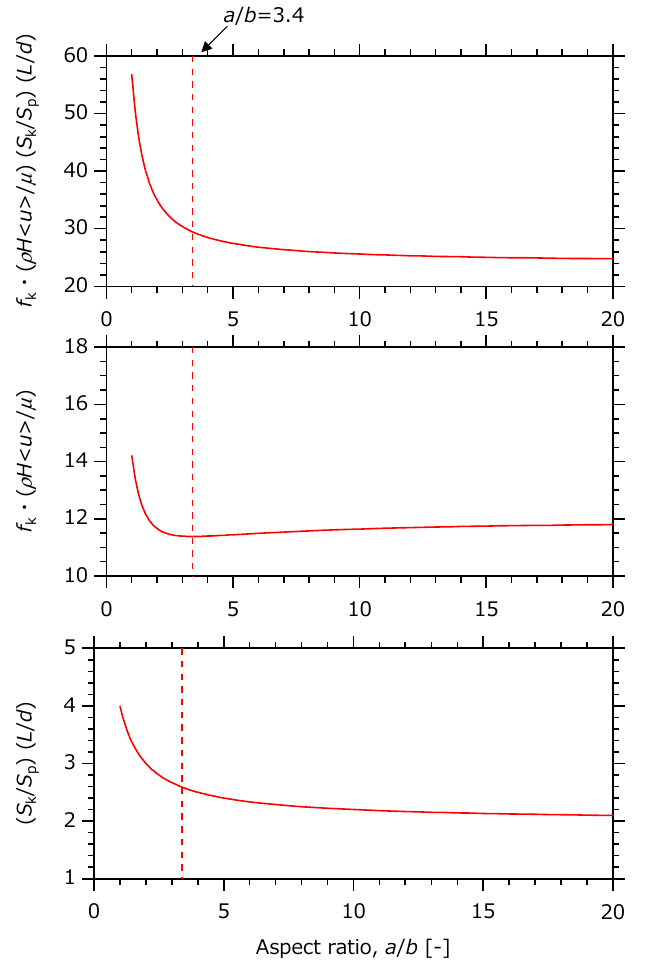
Figure 4. Aspect ratio dependence of dimensionless modulus related to pressure drop in analytical solution.